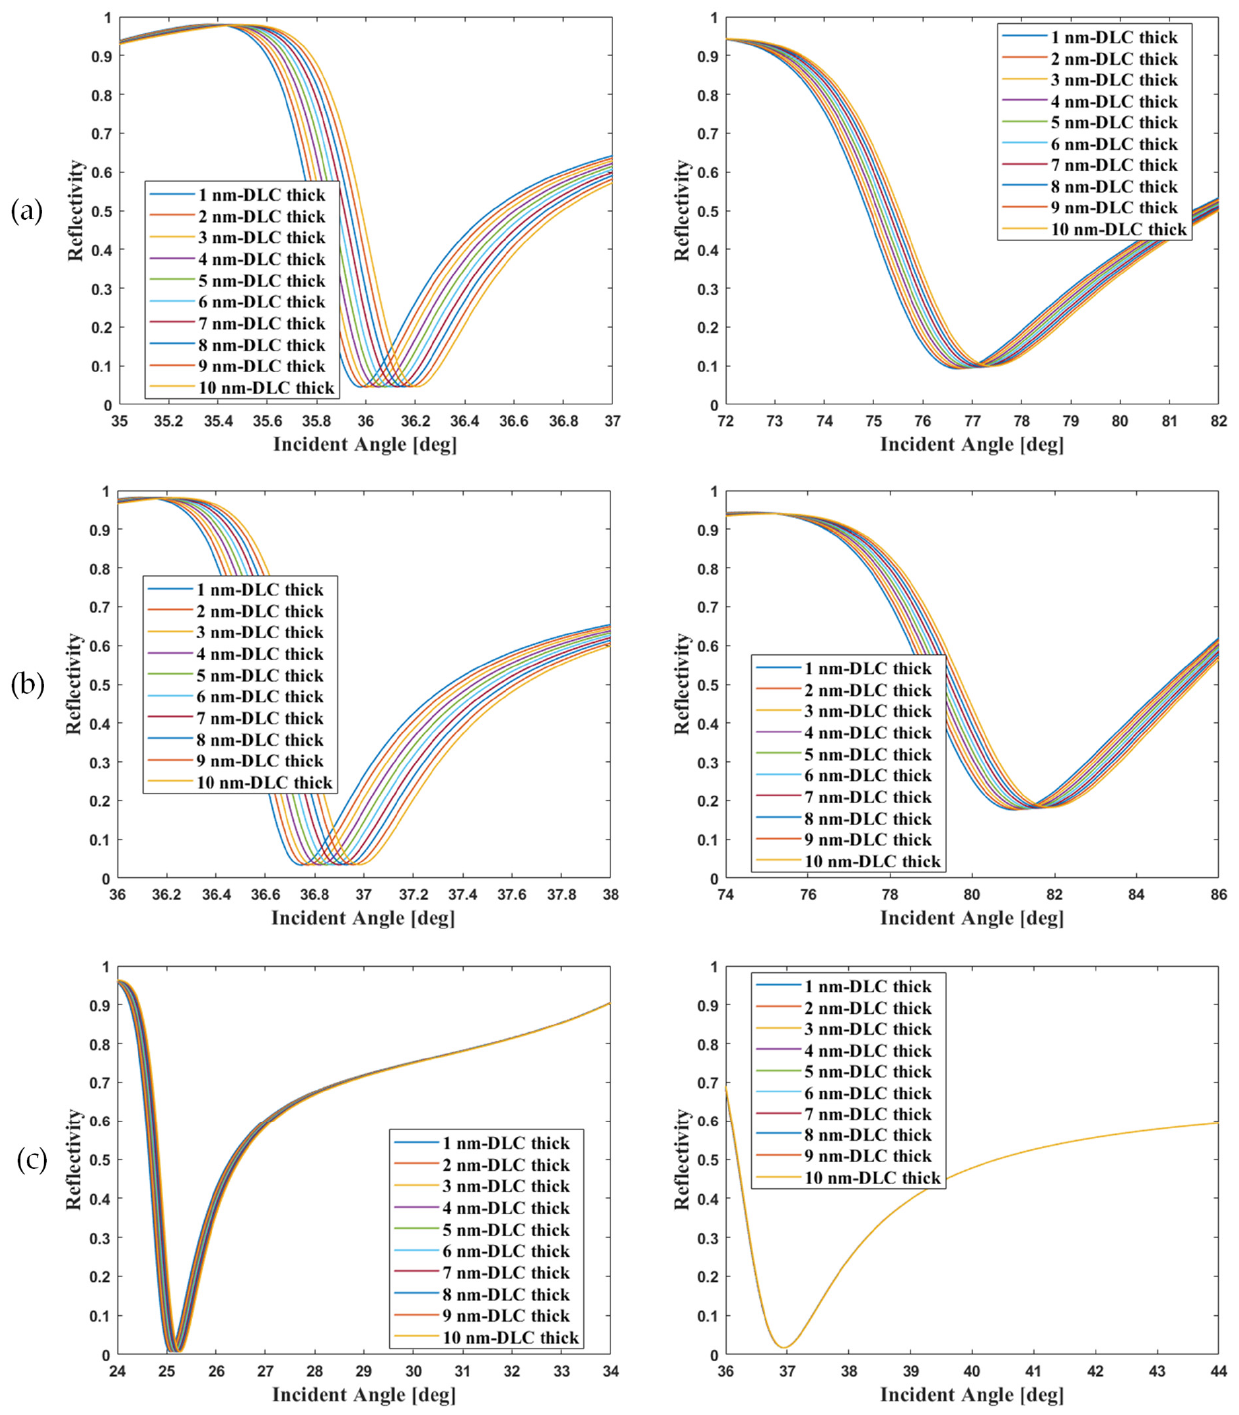
Figure 6. Calculated reflectivity spectra for TM-polarized incident light of the optimized ( a ) sap- phire prism/TiN/AlN/air sensor, ( b ) magnesium oxide prism/TiN/AlN/air sensor, and ( c ) silicon prism/TiN/AlN/air sensor, showing the shifts in reflectivity minima caused by deposition of DLC film thicknesses of 1–10 nm in steps of 1 nm.